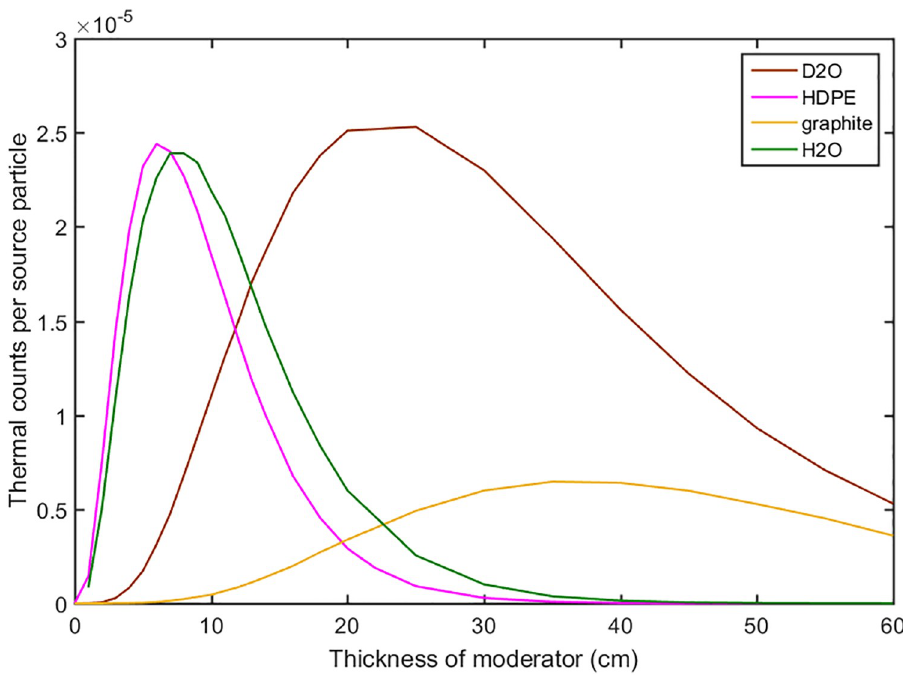
Fig 5. The thermal neutron flux versus the thicknesses of moderator with different materials.